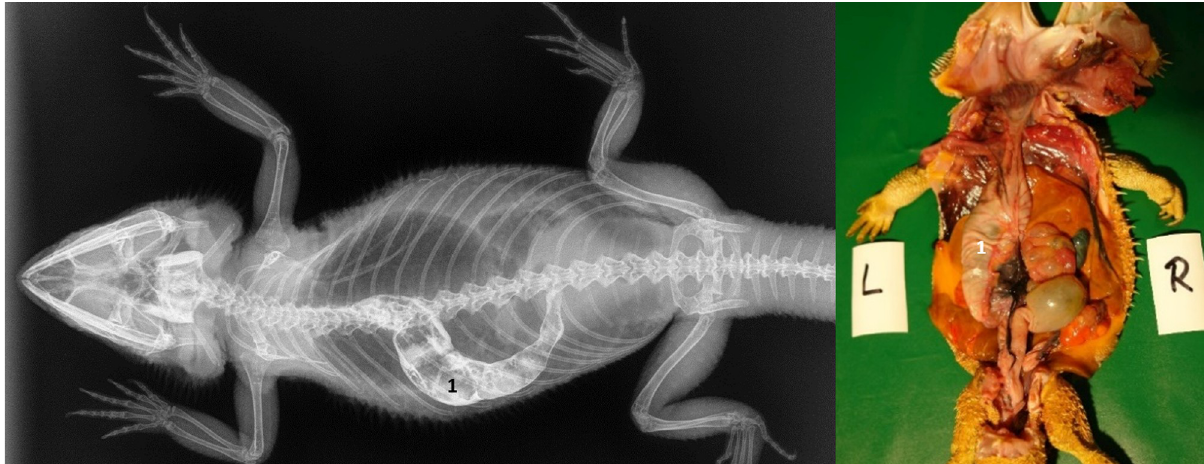
Fig 8. Dorsoventral (DV) radiograph 15 minutes after oral administration of BaSO 4 . 15 minutes after oral administration of BaSO 4 , (kV 42, mAs 2). The stomach (1) is visible as an elongated “C” and is primarily located on the left side of the coelom.